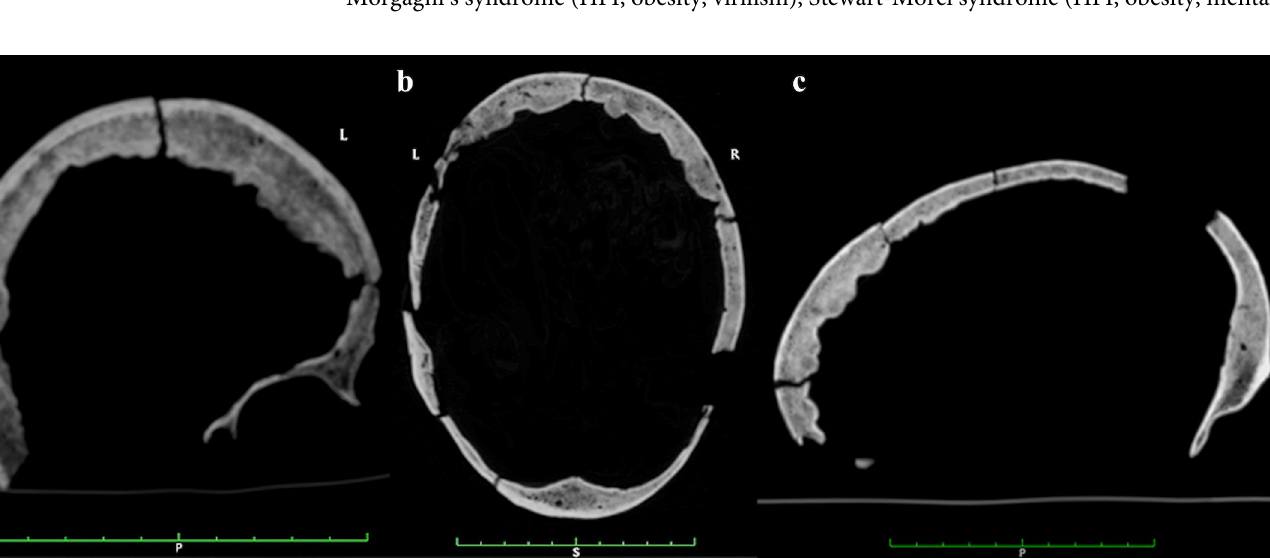
PLOS ONE | https://doi.org/10.1371/journal.pone.0281727 March 6,